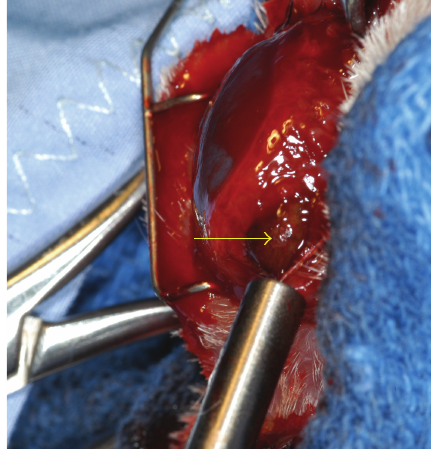
Figure 3: Intraoperative appearance. The conjunctiva has been dissected away and uveal tissue can be seen prolapsing through the region of scleral rupture (yellow arrow).